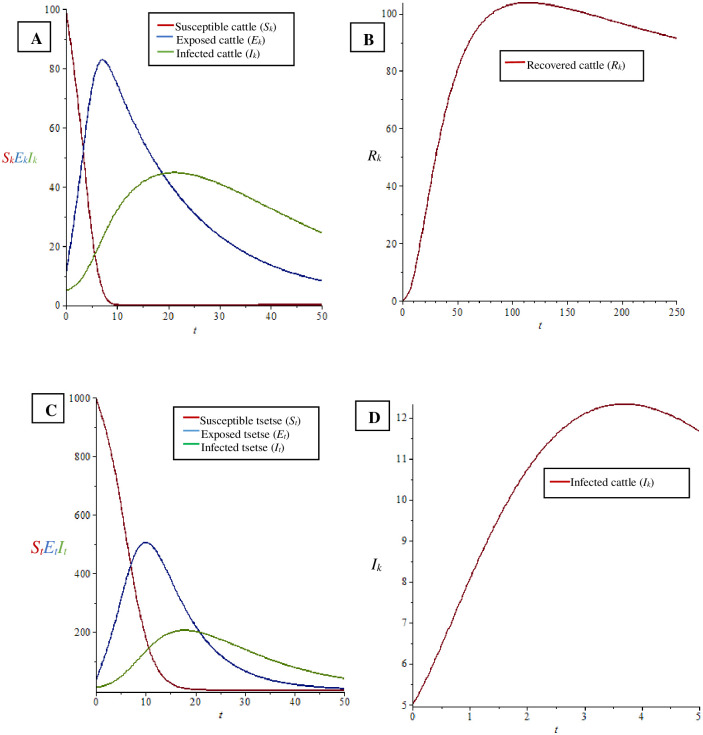
Behavioural conditions in different populations.A. The behaviour of cattle population when R01 < 1. B. The behaviour of recovered cattle when R01 < 1. C. The behaviour of tsetse fly population when R01 < 1. D. The behaviour of infected cattle when the tabanid and stomoxyine population increase with abundant presence of wildlife populations.